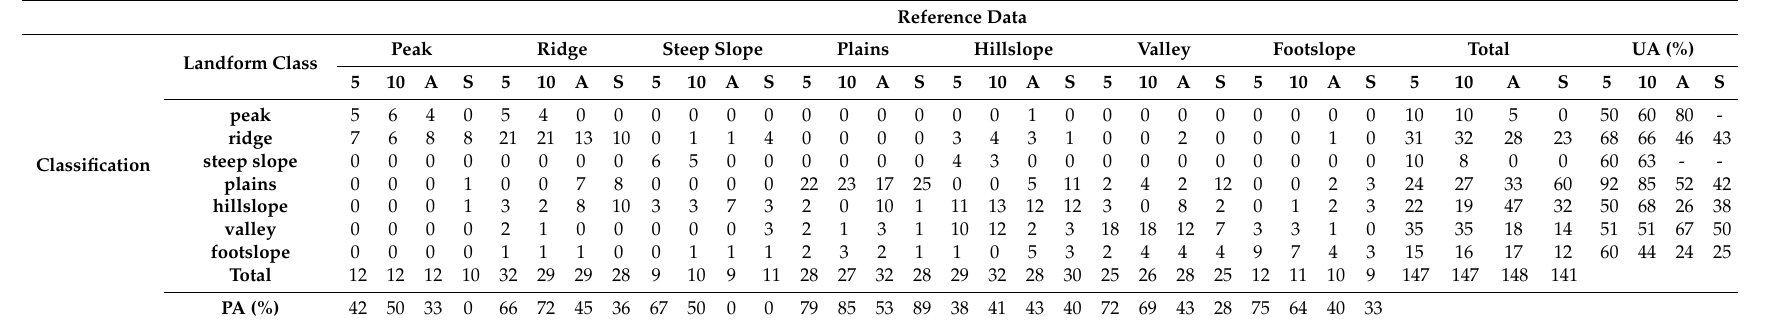
Table A3. Error matrix based on classified landform units for the object-based approach for the four different DEMs (5 = 5 m, 10 = 10 m, A = Aster 30 m, S = SRTM 30 m) with producer’s accuracy (PA) and user’s accuracy (UA).